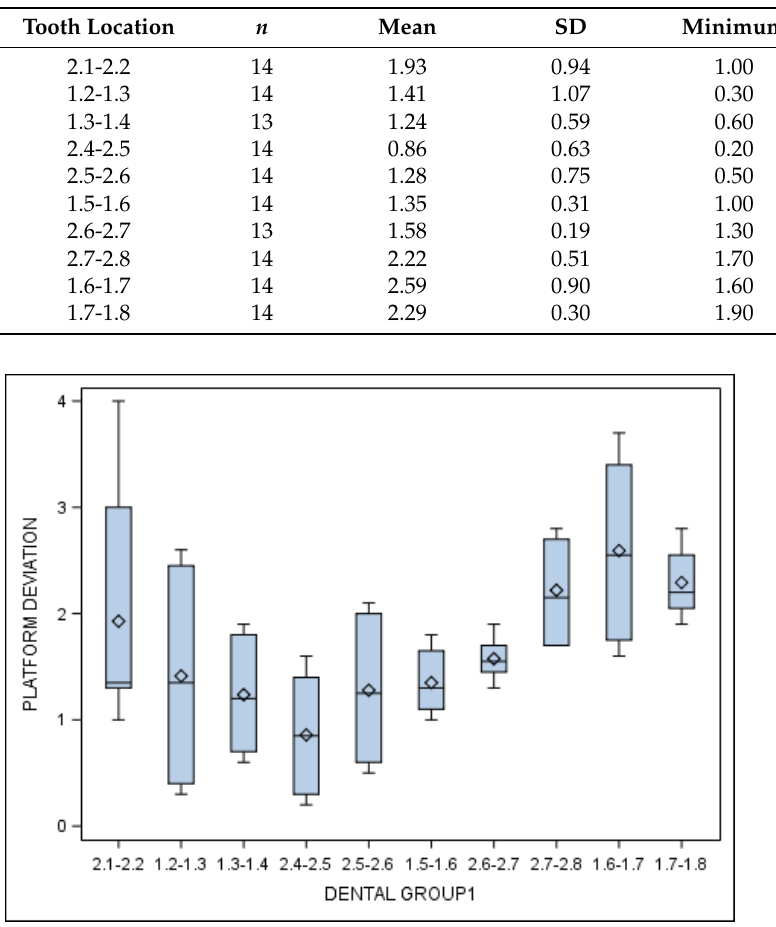
Figure 6. Box plot of the coronal entry-point deviations of the orthodontic micro-screws in the selected tooth positioning.